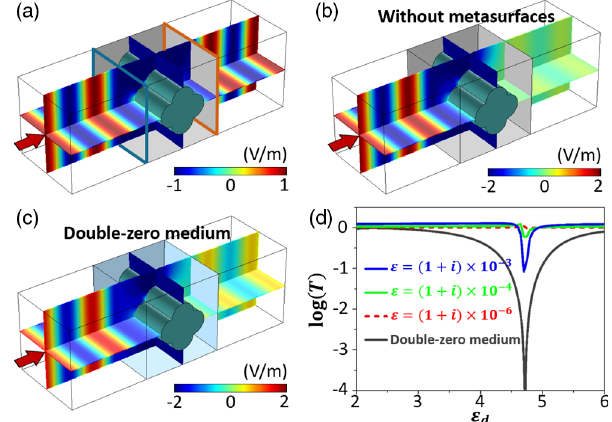
FIG. 5. (a) – (c) Distribution of E z for a dielectric cylinder of ε ¼ 4 with a random cross section embedded in (a) an ENZ d medium ( ε ¼ 10 − 3 þ 10 − 3 i ) with PT -symmetric metasurfaces, (b) an ENZ medium ( ε ¼ 10 − 3 þ 10 − 3 i ) without metasurfaces, and (c) a double-zero medium ( ε ¼ μ ¼ 10 − 3 þ 10 − 3 i ). (d) Trans- mittance as a function of the relative permittivity of the dielectric cylinder for the case of the double-zero medium without metasurfaces (gray solid lines) or the ENZ medium with the PT -symmetric metasurfaces (other